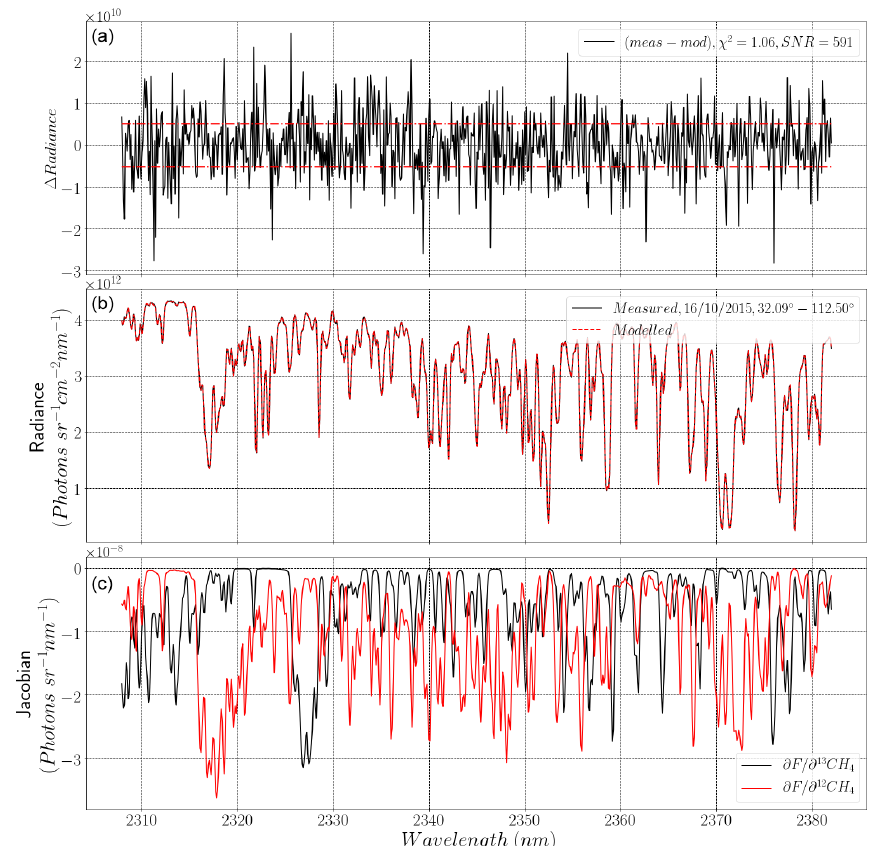
Figure 7. As Fig. 1 but focused on the TROPOMI/UVNS SWIR3